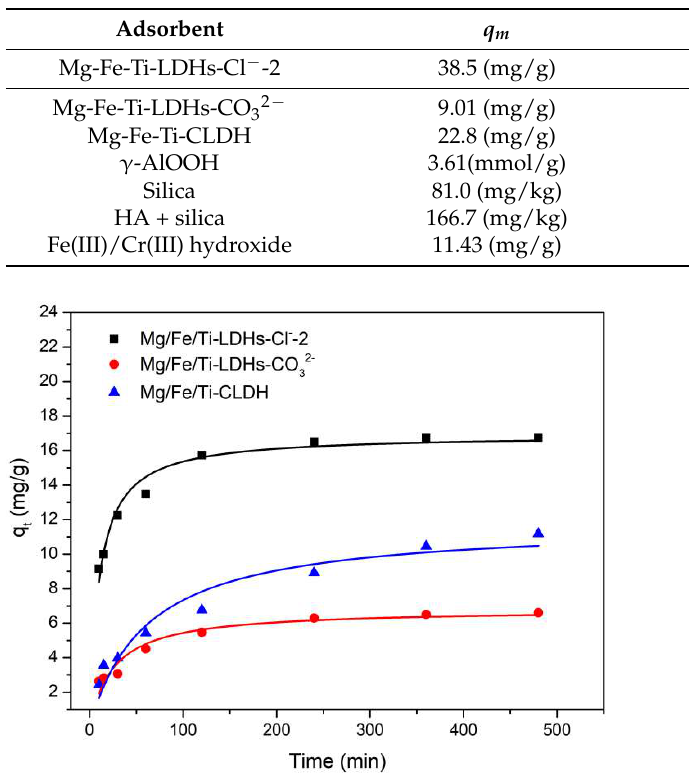
Figure 8. Effect of contact time on vanadate adsorption onto Mg-Fe-Ti-LDHs-Cl − -2, Mg-Fe-Ti-LDHs-CO 32 − and Mg-Fe-Ti-CLDH (experimental conditions: C 0 = 5 mg/L, adsorbent dosage = 10 mg, pH = 5.0, contact time = 10–480 min, T = 298 K).